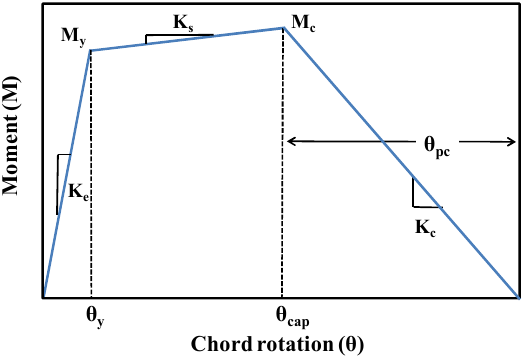
Figure 12. Backbone curve parameters (adapted from FEMA P695